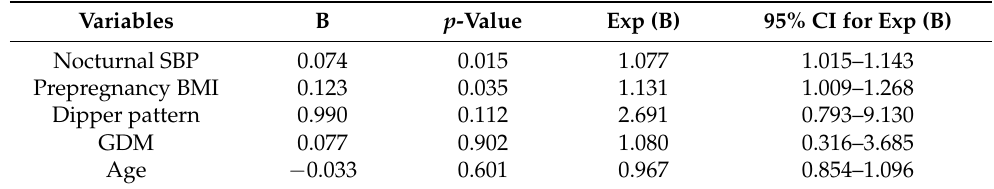
Table 4. Final model of the multivariable regression analysis for the risk prediction of HDP. B: Beta; Exp (B): beta exponent; 95% CI for Exp (B): 95% confidence interval for beta